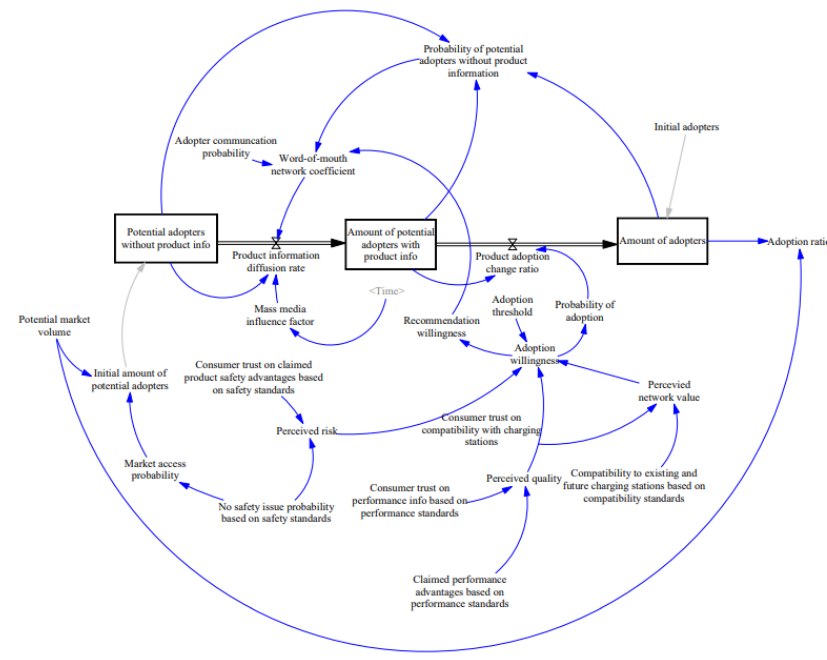
Figure 6. System Dynamics flow diagram of consumer adoption.